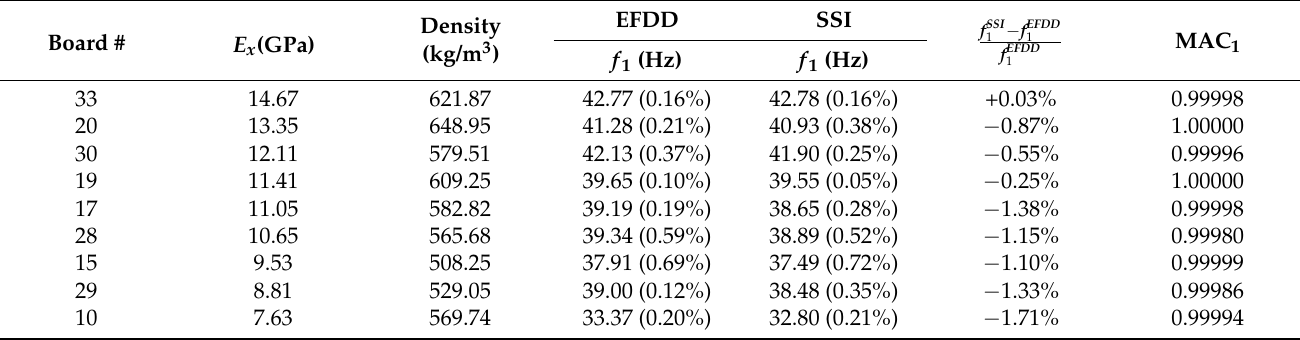
Table 3. Comparison of first resonant frequency and mode shape obtained with EFDD and SSI methods in different timber boards.